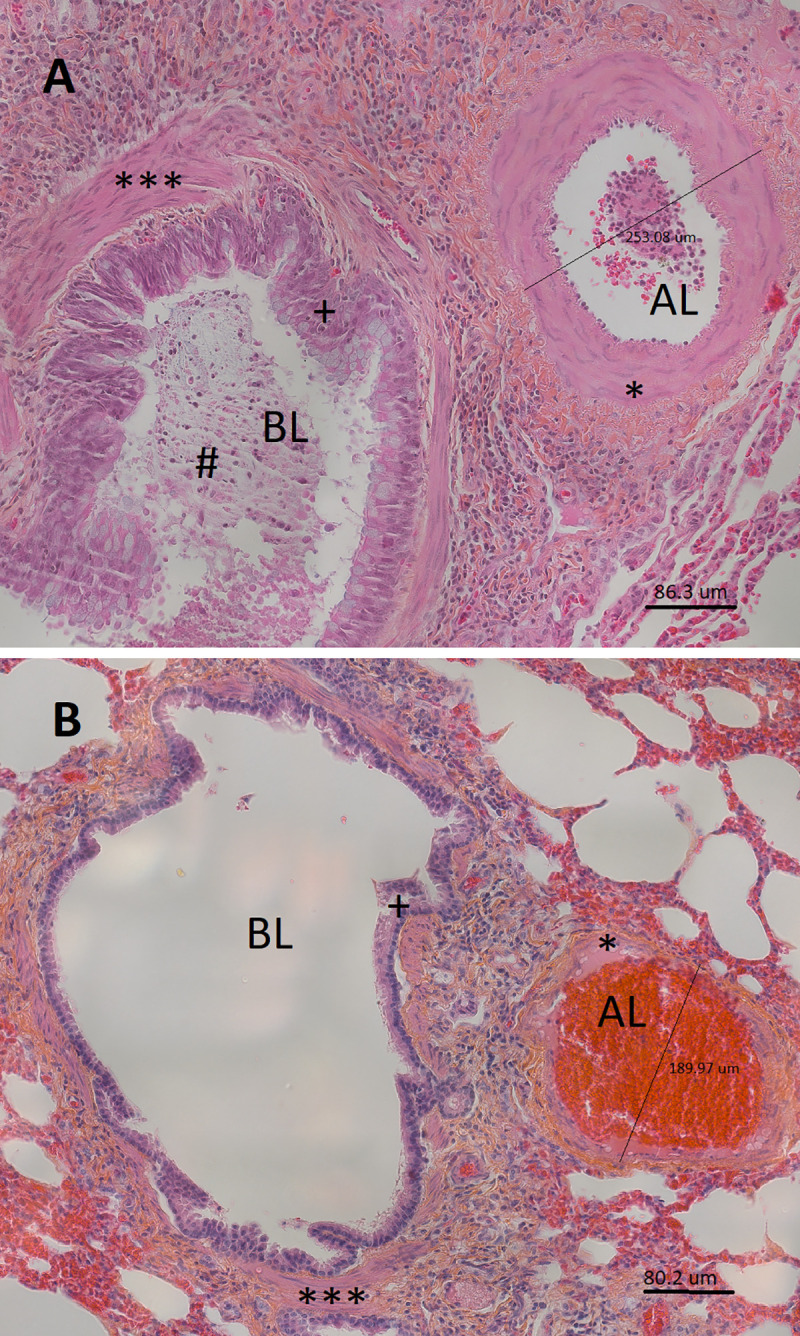
Muscular pulmonary artery and annexed bronchus of an asthmatic horse in exacerbation (A) and of a control horse (B) in study 1 (histological sections, 40X, hematoxylin eosin saffron). The bronchus lumen (BL) and artery lumen (AL) are identified. The measurement of the artery external diameter is also reported. In these micrographs, thickening of the muscular pulmonary artery wall (*) is visually detectable in the asthmatic horse (A), compared to a control animal (B). Notably, asthma-related airway remodeling is also detectable in the micrograph from the asthmatic horse (A), with mucus accumulation in the airway lumen (#), epithelial thickening (+) and increased airway smooth muscle mass (***), compared to a control (B).